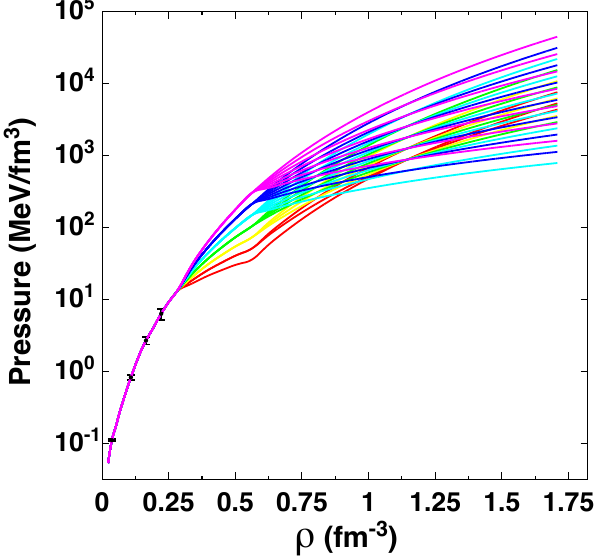
Figure 3. Pressure in β -stable matter as a function of density. The figure shows the spreading of the pressure values due to the matching of polytropes at two densities, ρ 1 = 0.277 fm − 3 and ρ 2 = 0.506 fm − 3 . Each group of curves with the same color contains EoSs with the same Γ 1 and varying Γ 2 . The microscopic predictions (single pink curve prior to the first matching point), are obtained at N 3 LO and cutoff equal to 450 MeV.